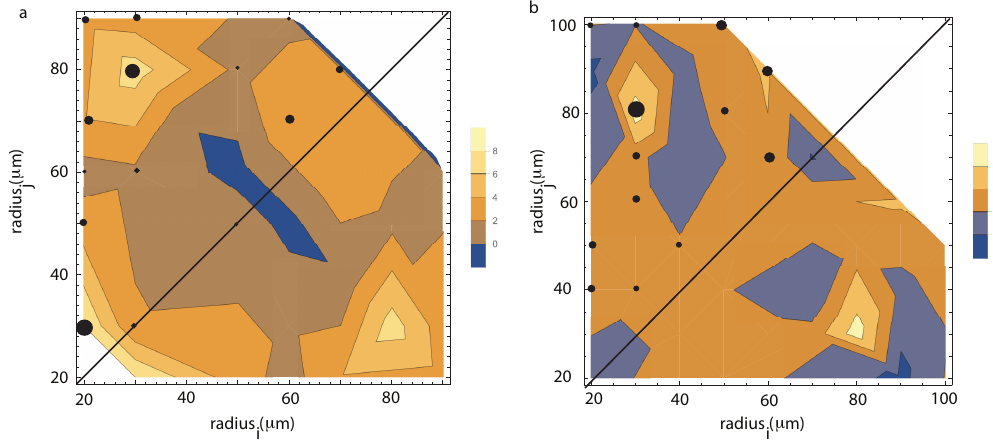
Figure 7. ( a ) the NFOV images of liquid droplets collisions inside the large vapor bubble. The landscape of the positive transition rates is dominated by two mechanisms: (1) low and similar radii (20 µ m with 30 µ m); and (2) asymmetric sizes at 30 µ m and 80 µ m; ( b ) NFOV images of vapor bubbles inside the liquid matrix. The transition rates for binary collisions are dominated by 30 µ m and 80 µ m sizes. At the same time, similar size collisions are much more likely than in the case of liquid droplets. All contour plots are shown on a logarithmic scale. The size of the solid circle is proportional to the transition probability